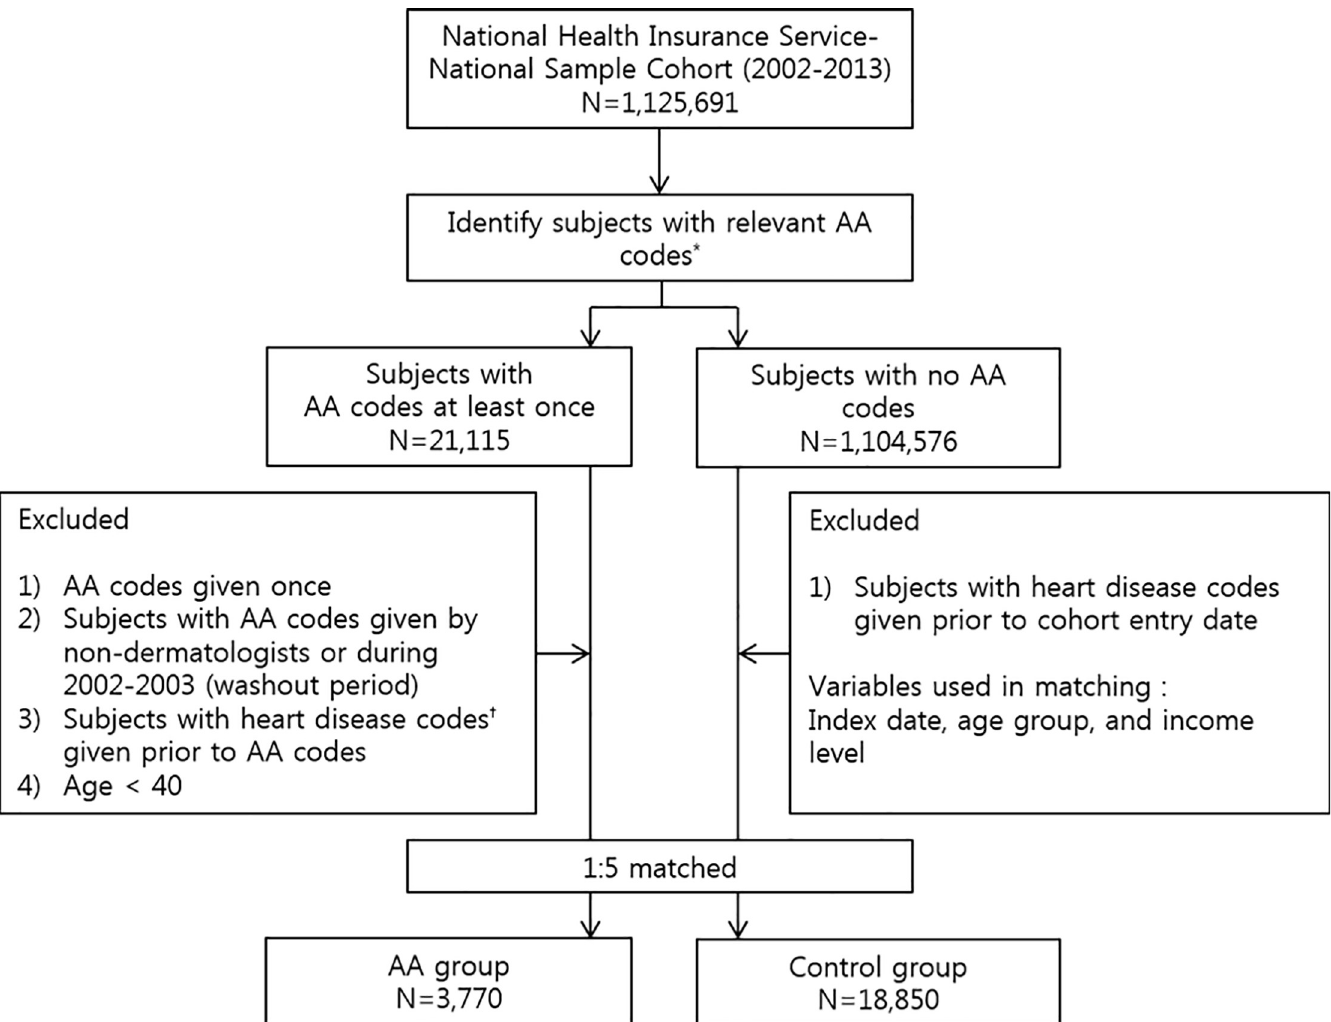
Fig 1. Study flowchart. AA, alopecia areata; AT, alopecia totalis; AU, alopecia universalis; HD, heart disease. � AA codes: L63 and its sub-classified codes. † HD codes: I20 (angina), I21-I25 (myocardial infarction), I50 (heart failure).